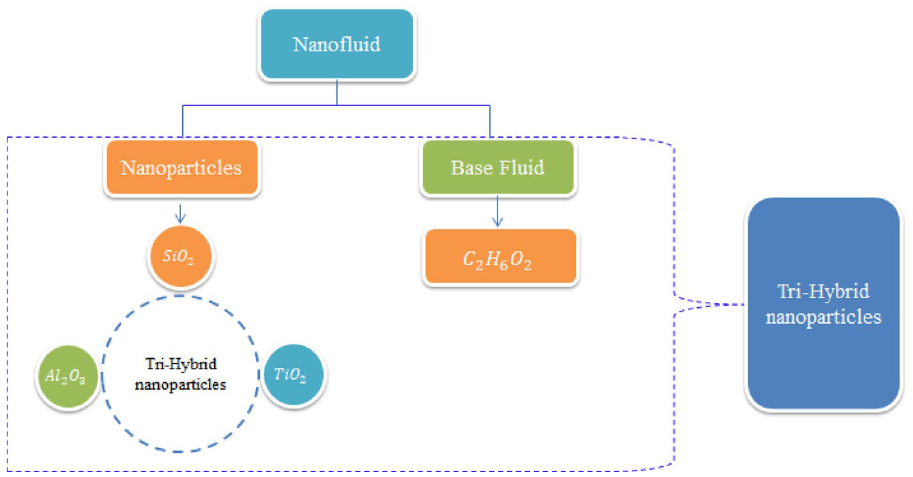
Figure 1. Preparation scheme of tri-hybrid